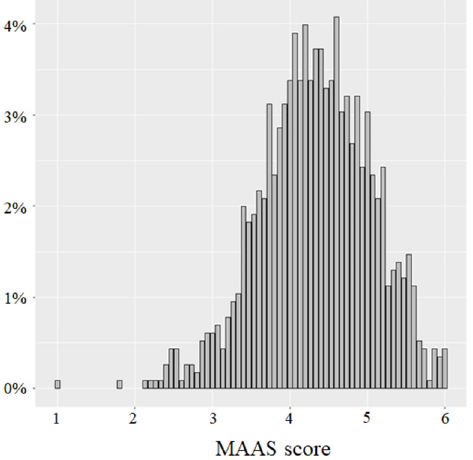
Figure 2. Distribution of the MAAS scores for our sample. Table 3. Comparison of the MAAS scores of general populations from different